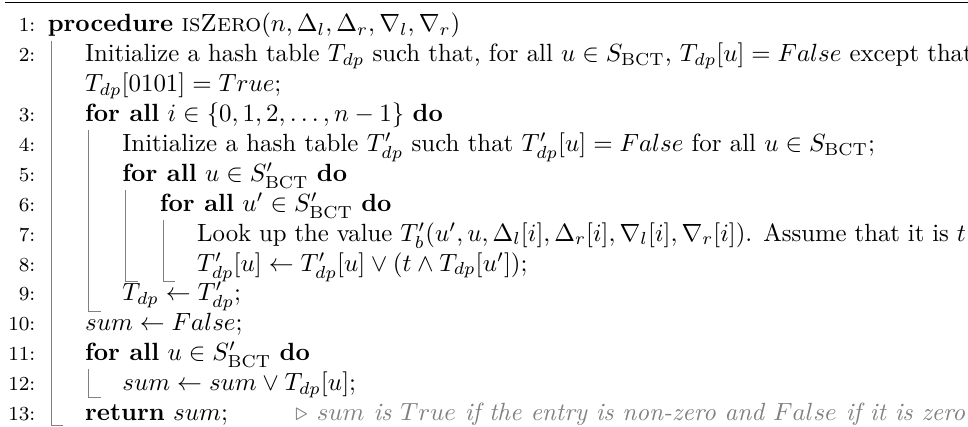
Algorithm 3 A dynamic programming algorithm to check an entry in